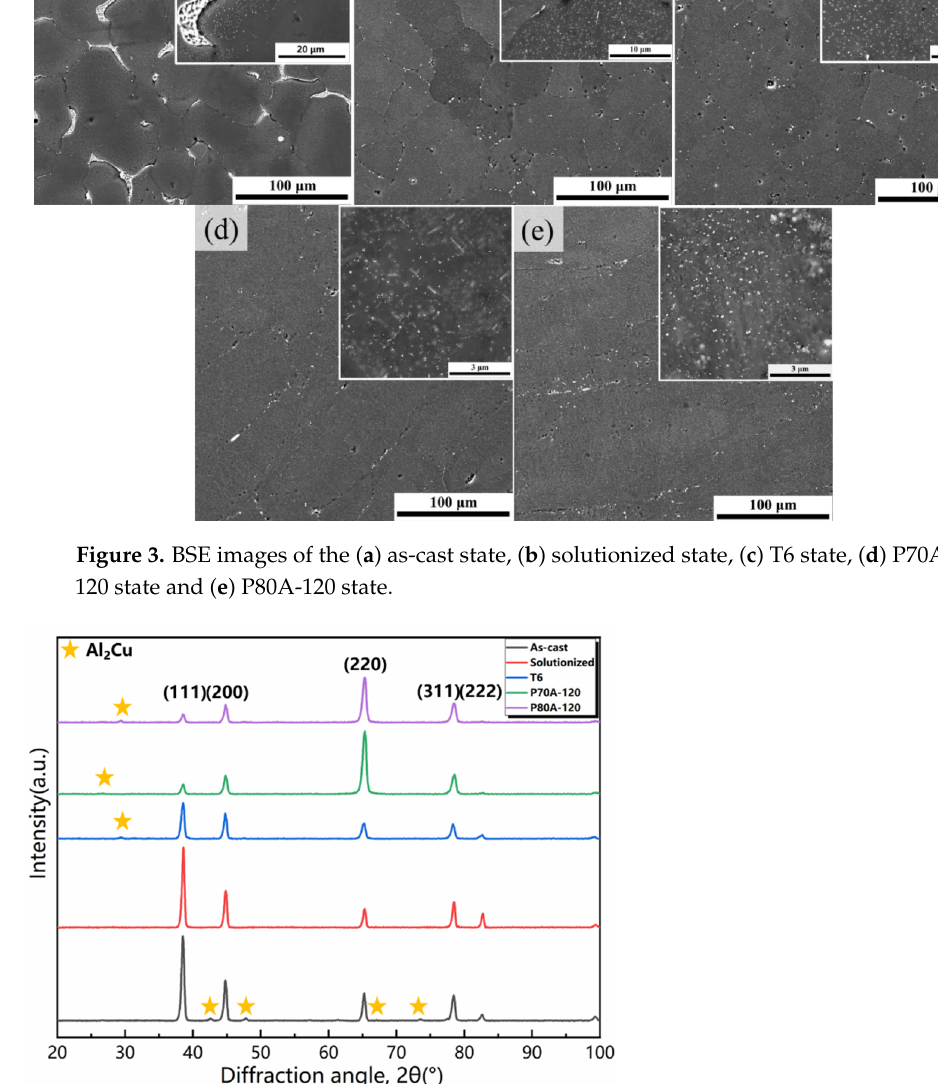
Figure 4. XRD patterns of the as-cast, solutionized, T6, P70A-120 and P80A-120 state. For the P70A-120 (Figure 3d) and P80A-120 (Figure 3e) samples, the grains were stretched along the rolling direction, with the remnant broken second phase distributing along the prolonged grain boundaries. Additionally, the inset of Figure 3d shows that the P70A-120 sample contained numerous fine particles and a certain amount of T phases with a length of approximately 1 μ m. Similarly, the inset of Figure 3e shows that massive dis- persoids distributed homogeneously all over the grains. According to the XRD patterns plotted in Figure 4, the three peak-aged samples with different pre-deformation degrees had the same diffraction peaks of the Al 2 Cu phase, identifying the second phase particles observed in Figure 3c–e. Moreover, for the T6 sample the strongest peak of the Al matrix in the map appeared at the angle of 38°, while that of the P70A-120 and P80A-120 samples